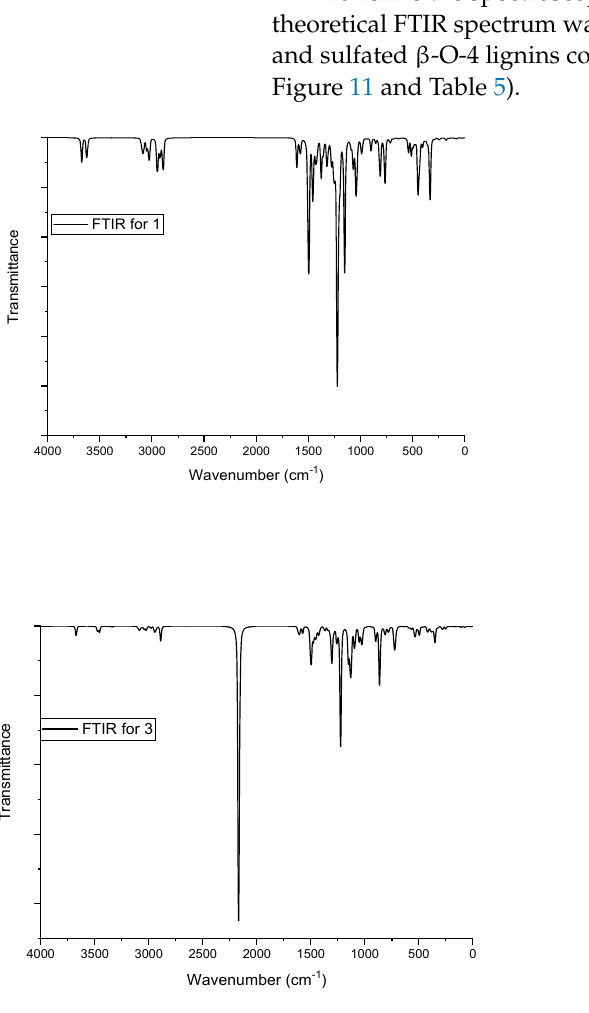
Figure 11. Theoretical FTIR spectra of the investigated molecules. Table 5. Some important wavenumbers (cm − 1 ) scaled by a factor of 0.9608 for the investigated mol ‐ ecules.